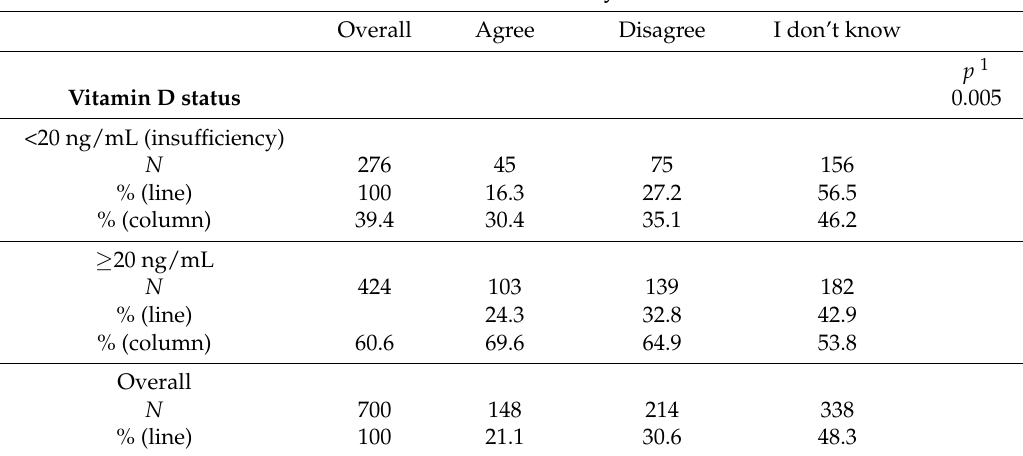
Table 3. Opinion regarding vitamin D status and measured vitamin D status, NutriNet-Santé cohort, France